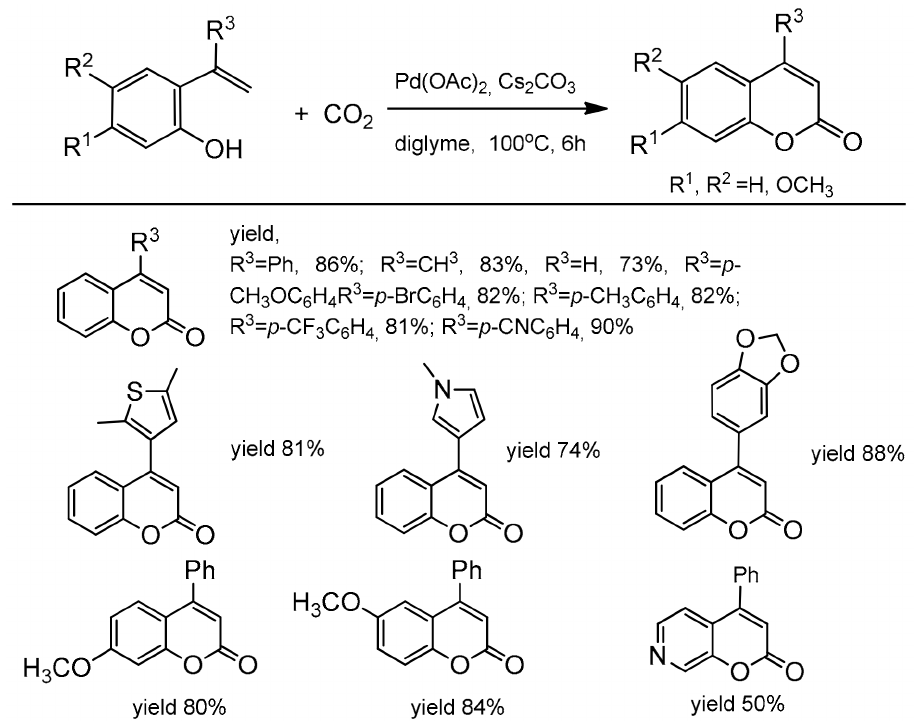
Scheme 19. Pd-catalyzed reaction of 2-hydroxystyrenes with carbon